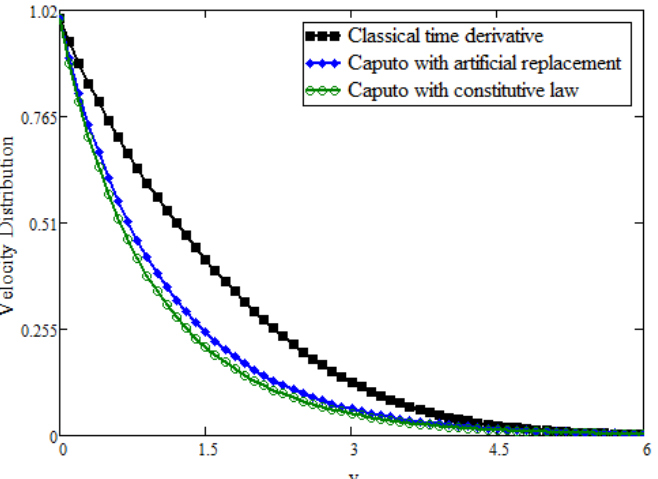
Figure 12. Comparison of velocity between classical time derivative, Caputo fractional model with artificial replacement and Caputo model with generalized constitutive